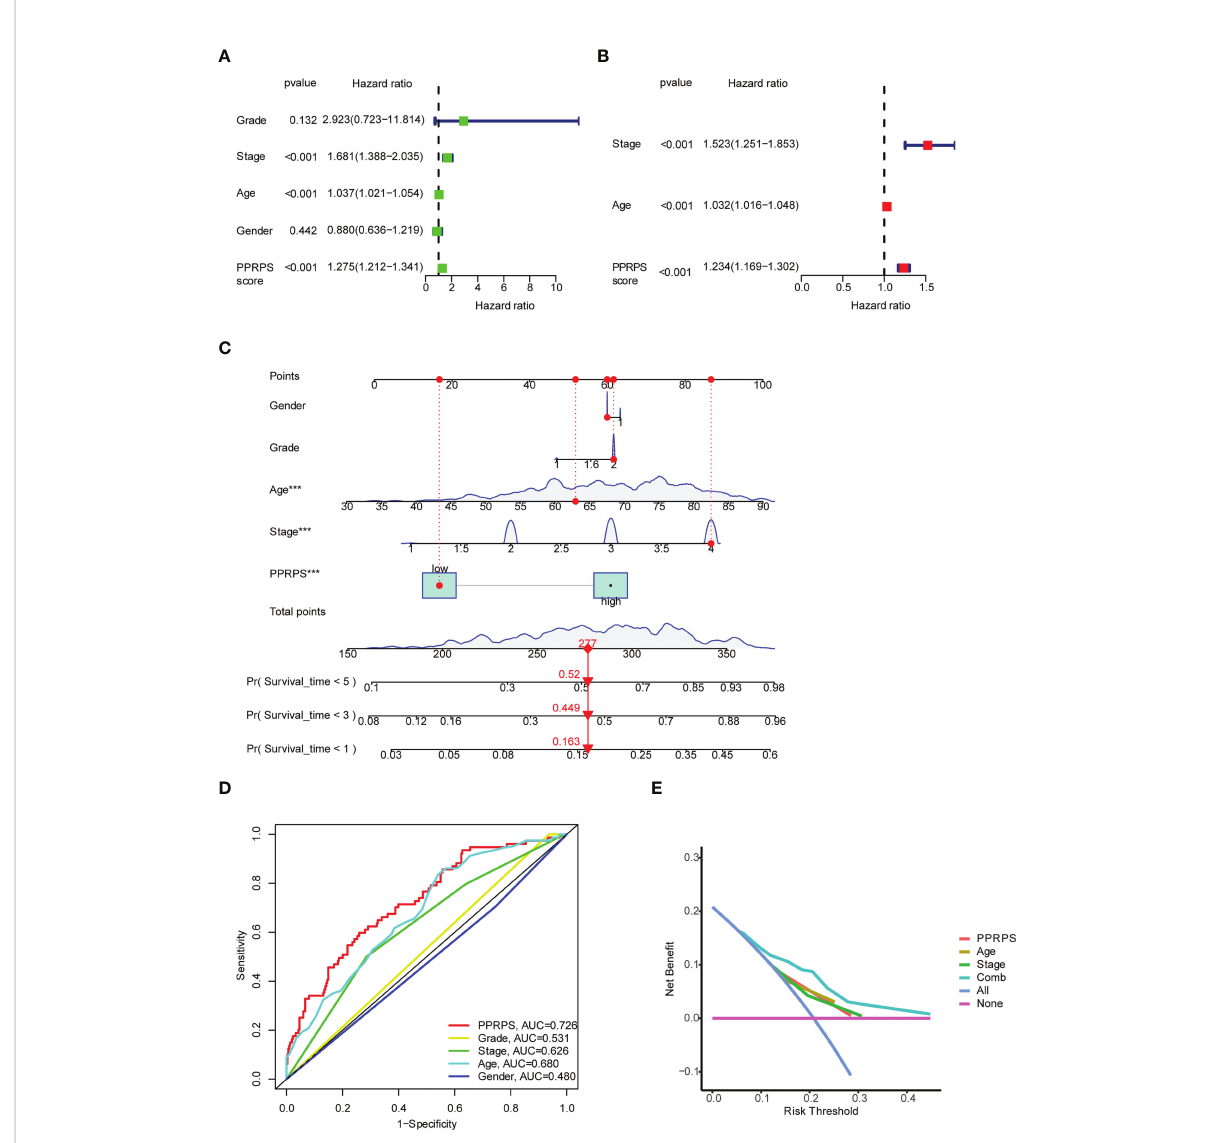
FIGURE 4 Univariate and multivariate Cox analyses of the PPRPS and clinical characteristics based on Pan-PCD signature genes. (A, B) Predicting overall survival (OS) based on univariate (A) and multivariate (B) Cox analyses. (C) Nomogram to predict the 1-, 3- and 5-year OS of bladder cancer patients. (D) Comparison of 1-year ROC curves with clinicopathological features. (E) Decision curve analysis (DCA) of the clinicopathological model predicts the net increase in the risk of bladder